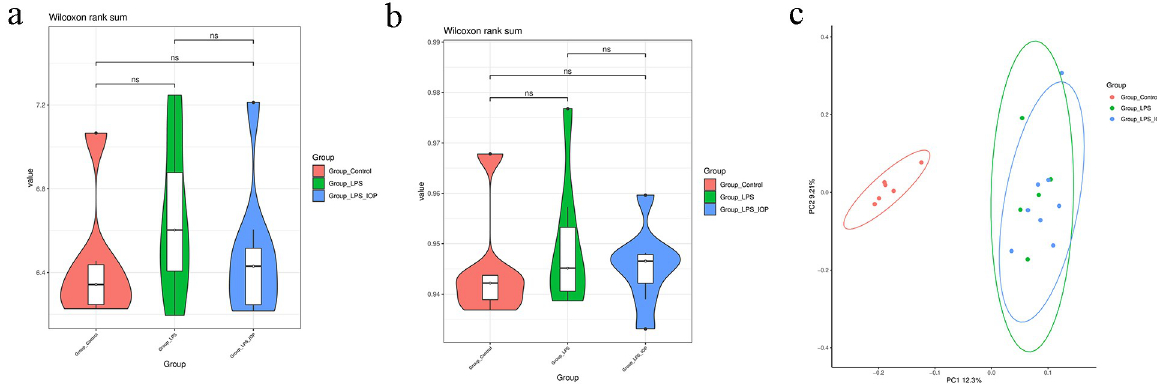
Fig 3. The total structure of the gut microbiota. (a). Shannon index of α diversity analysis. (b). Simpson index of α diversity analysis, ns means no difference. (c). Principal Co -ordinates analysis ( PCoA ) of β diversity.